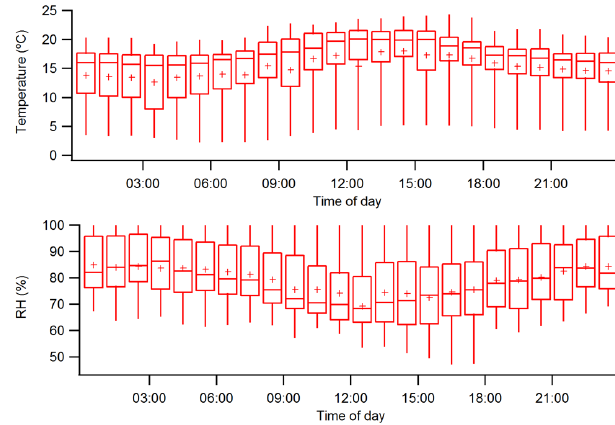
Fig. 6. Diurnal variation of temperature (top) and relative humidity (bottom) during the campaign